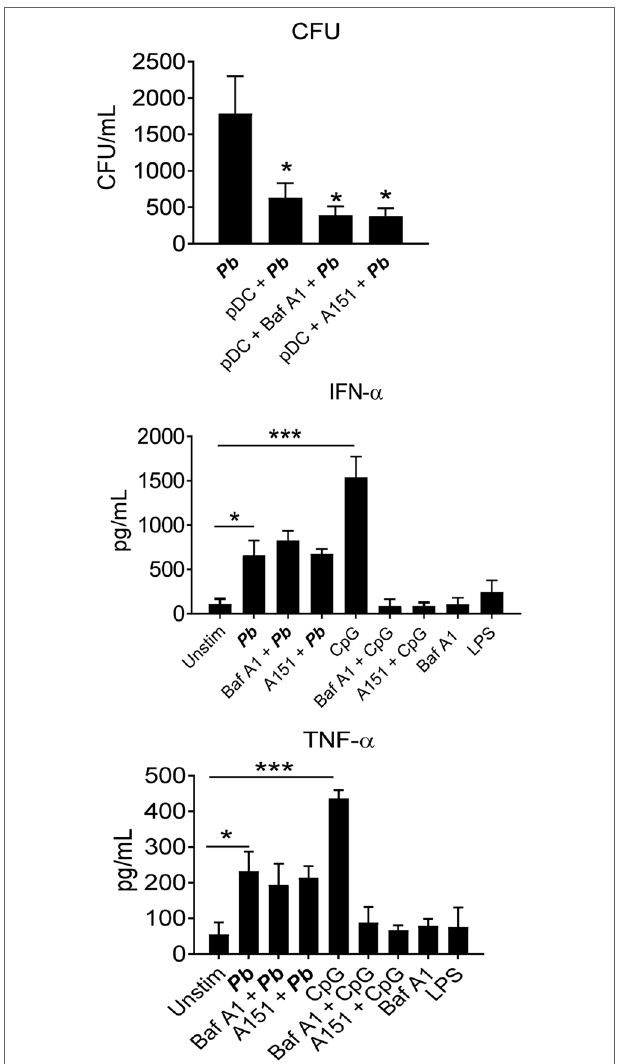
FigUre 4 | Toll-like receptor (TLR)-9 is not used by plasmacytoid dendritic cells (pDCs) to sense Paracoccidioides brasiliensis yeast cells. peripheral blood mononuclear cells were separated into pDC-positive populations (pDCs + ) using magnetic beads conjugated to anti-CD304 antibody. The cells (1 × 10 5 /well) were challenged overnight with P. brasiliensis yeast cells (2 × 10 3 ). Some wells were kept unstimulated, with only the yeasts, and LPS (100 ng/mL). Some cultures were treated with an TLR-9 antagonist (A151, TTAGGG, 10 µg/mL) or with the TLR-9 inhibitor Bafilomycin A1 (10 µg/mL) before challenging either with the yeasts or with the positive control for TLR-9 activation CpG (100 ng/mL). After 18 h of culture, the plates were centrifuged and the supernatant was collected for cytokine measurements by ELISA. The pellet was lysed and suspended in 200 µL of phosphate-buffered saline. Next, 100 µL was transferred to BHI medium, and the colonies (CFU) were counted for 15 days. Data represent the means ± SE of the CFU and cytokine concentrations from three donors, tested in triplicate. * p < 0.05 comparing the group maintained only with the fungus with the